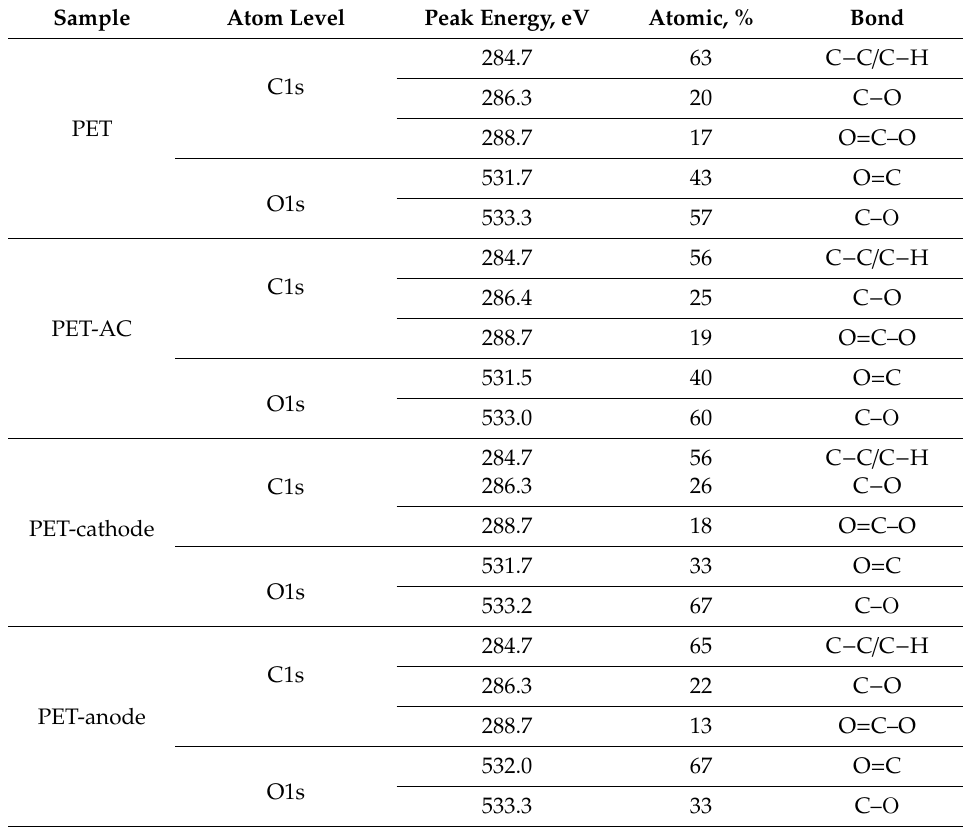
Table 3. Deconvolution of X-ray photoelectron spectroscopy (XPS) C1s and O1s core-level spectra of initial and plasma-treated PET